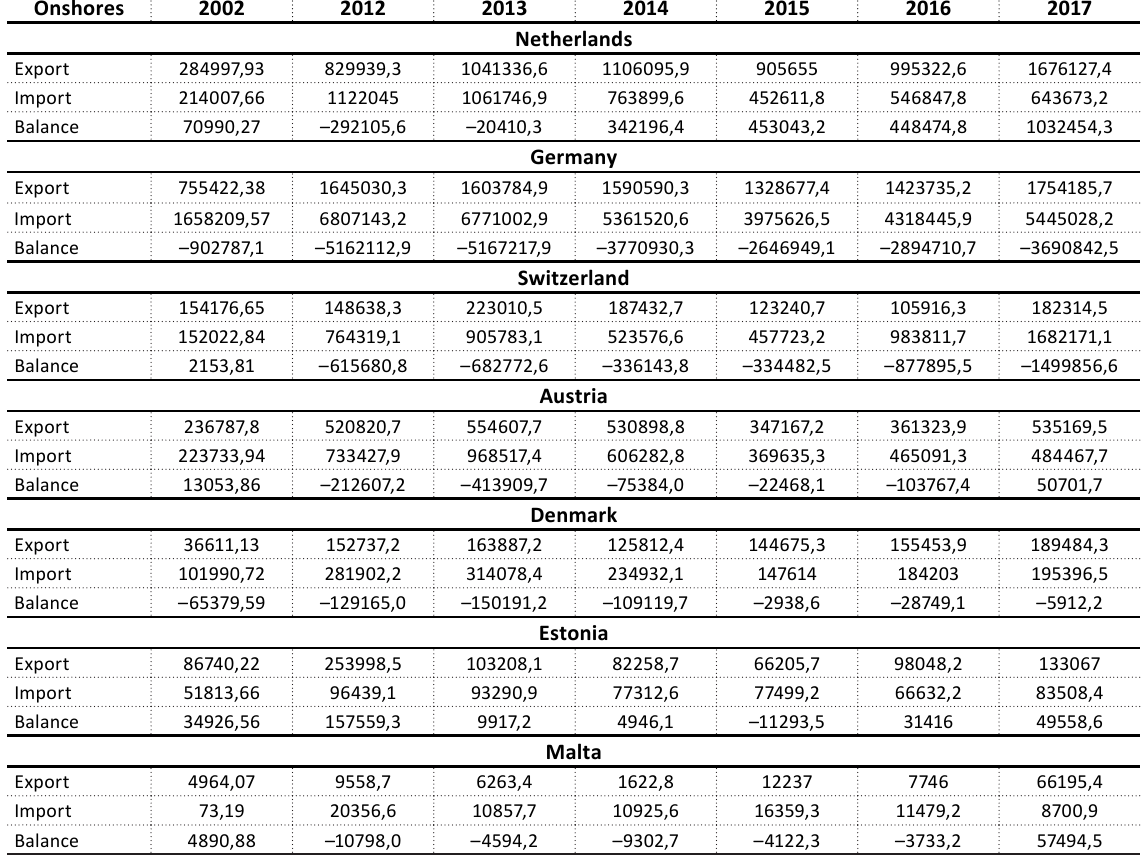
Table 4. Dynamics of Ukrainian international trade indicators with onshores during 2002–2017, USD thsd. Source: Data from the State Statistics Committee of Ukraine, World Bank.